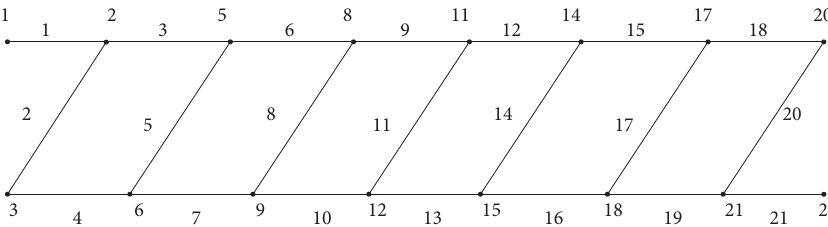
Figure 11: A classical mean labeling of SL